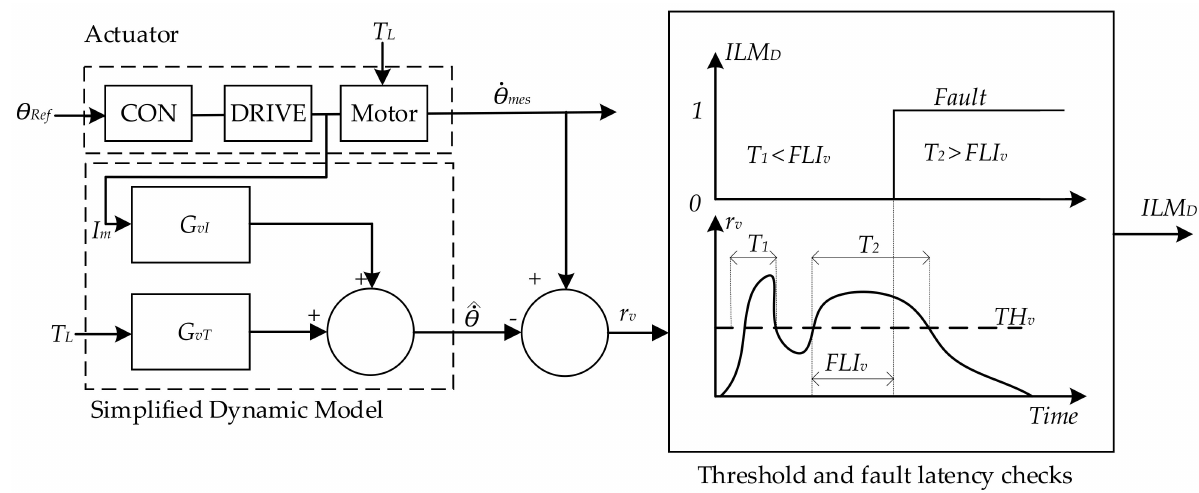
Figure 17. The principle of an enhanced ILM